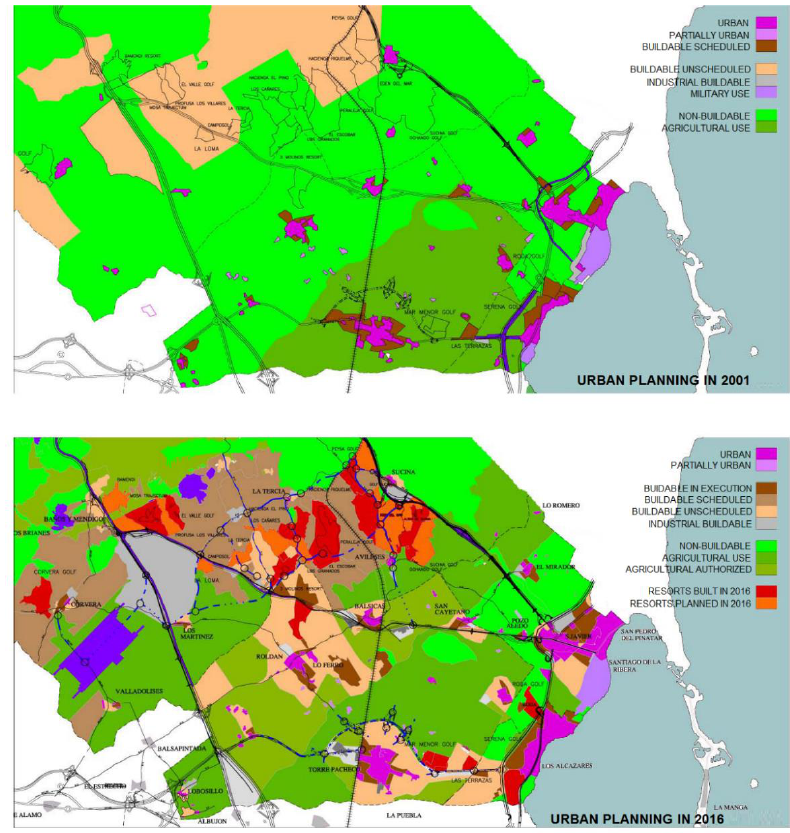
Figure 12. Comparison between the projected urban planning in the Mar Menor watershed in 2001 and in 2016. Source: Ref. [18].